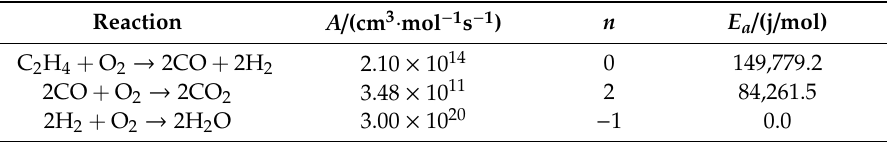
Table 1. Chemical reaction